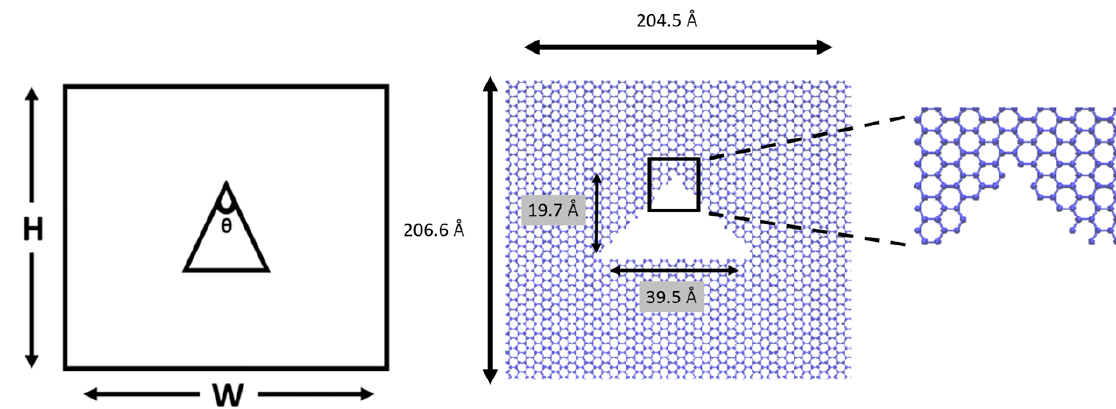
Figure 1. A snapshot of the configuration of Angle90, which is a single layer of graphene with a pre-crack in an isosceles triangle shape with a vertex angle of 90°. Left: the system size and the isosceles triangle sides. Right: a zoomed-in plot of the crack tip. The system of the pre-cracked single-layer graphene with the crack shape of an isosceles triangle with a vertex angle of 90° is denoted as Angle90 for convenience.